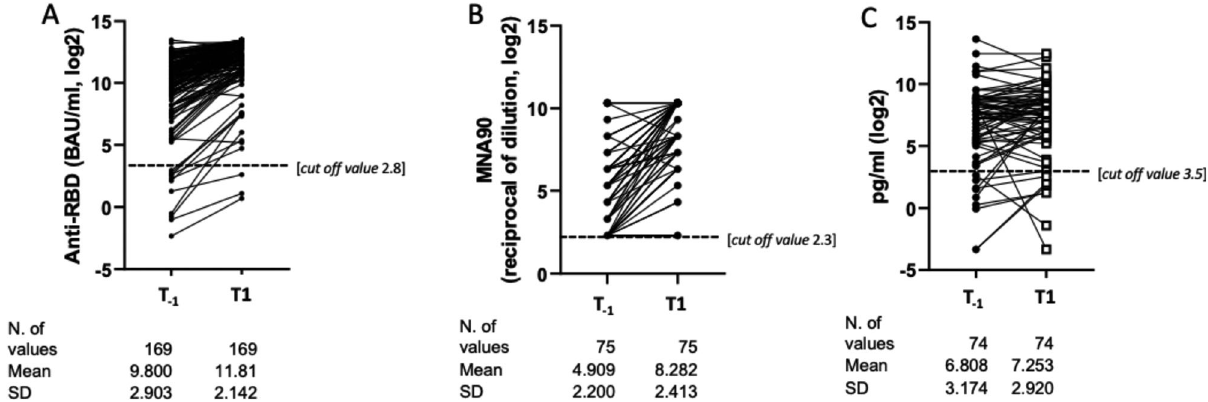
Fig. 1 | Comparison of the mean log 2 of anti-RBD IgG, MNA 90 and IFN- γ from 1 month response after the 2nd dose (T − 1 ) and after the 3 rd dose (T1). A – C Mean log 2 change of anti-RBD IgG ( A ),MNA 90 ( B ) and IFN- γ ( C ) from 1 month response after the 2nd dose (T − 1 ) and after the 3 rd dose (T1) [Paired t-test, 2-sided no